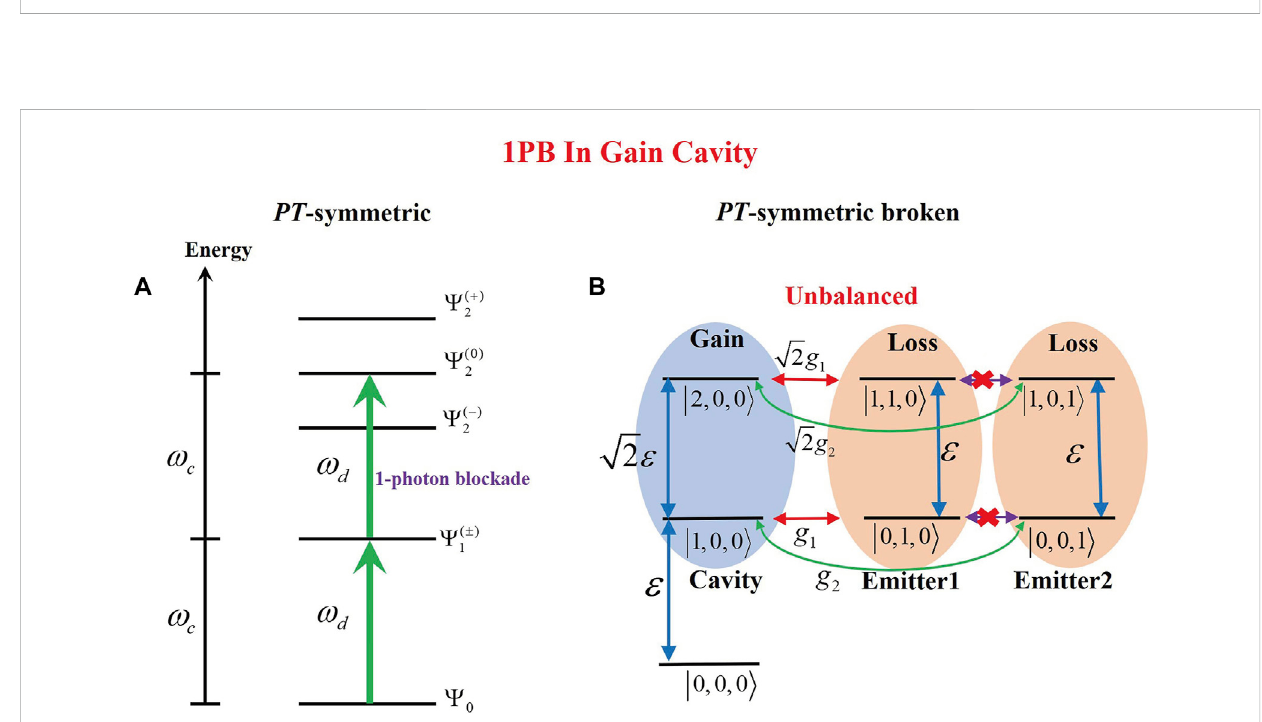
Level diagram of the quantum states for the cavity QED with the gain cavity under the weak cavity-driven assumption: (A) dressed states and (B) quantum